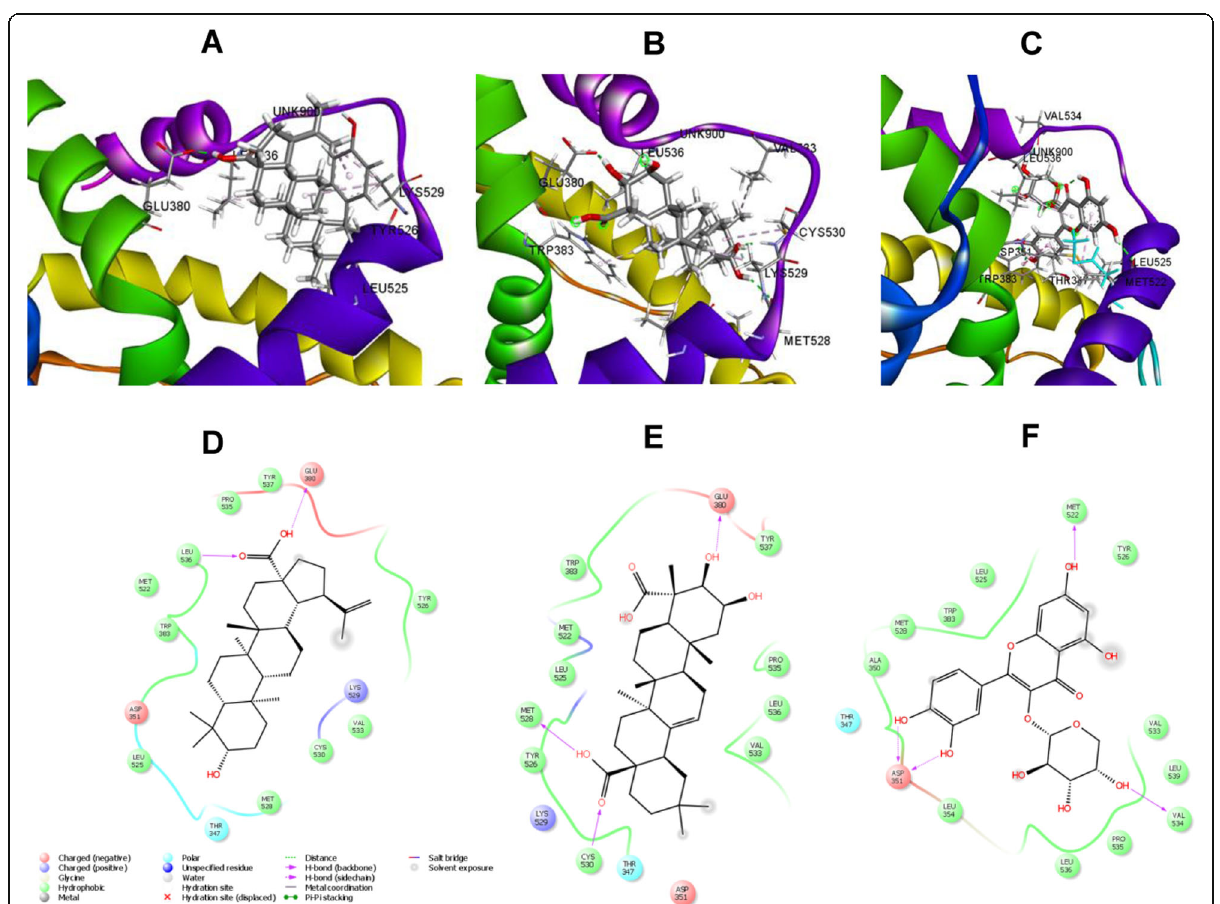
Fig. 4 Docking results. Best ranked pose of Betulinic acid ( a ), Catsanogenin ( b ), and Quercetin-3- α -arabinoside ( c ) in the binding pocket of estrogen receptor alpha (PDB: 3ERT) and 2D representation of key interactions in the binding pocket for Betulinic acid ( d ), Catsanogenin ( e ), and Quercetin-3- α -arabinoside ( f